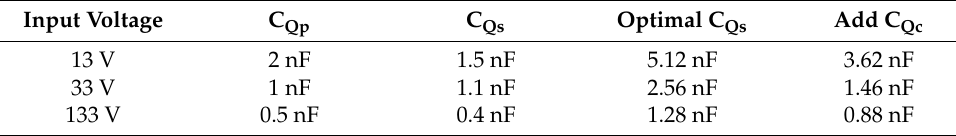
Table 6. Optimum parasitic capacitance condition.